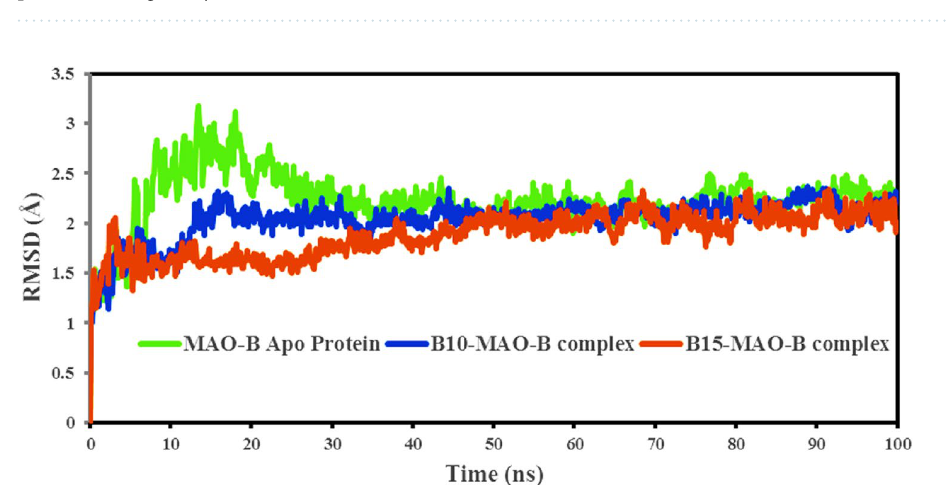
Figure 5. The 2D and 3D binding poses of promising compounds B10 ( A ) and B15 ( B ) in the hMAO-B protein binding cavity (PDB ID: 2V5Z).